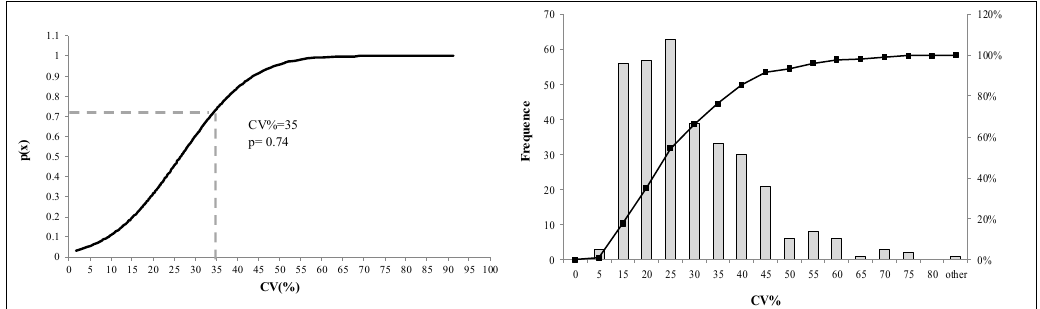
Figure 2. Control of the level of variability of values obtained by application of the decision tree based on the frequency distribution of CV%. CV% = variability of the median values with respect to the mean value. The frequency distribution was also expressed as cumulative probability by t -test (Student’s test distribution).